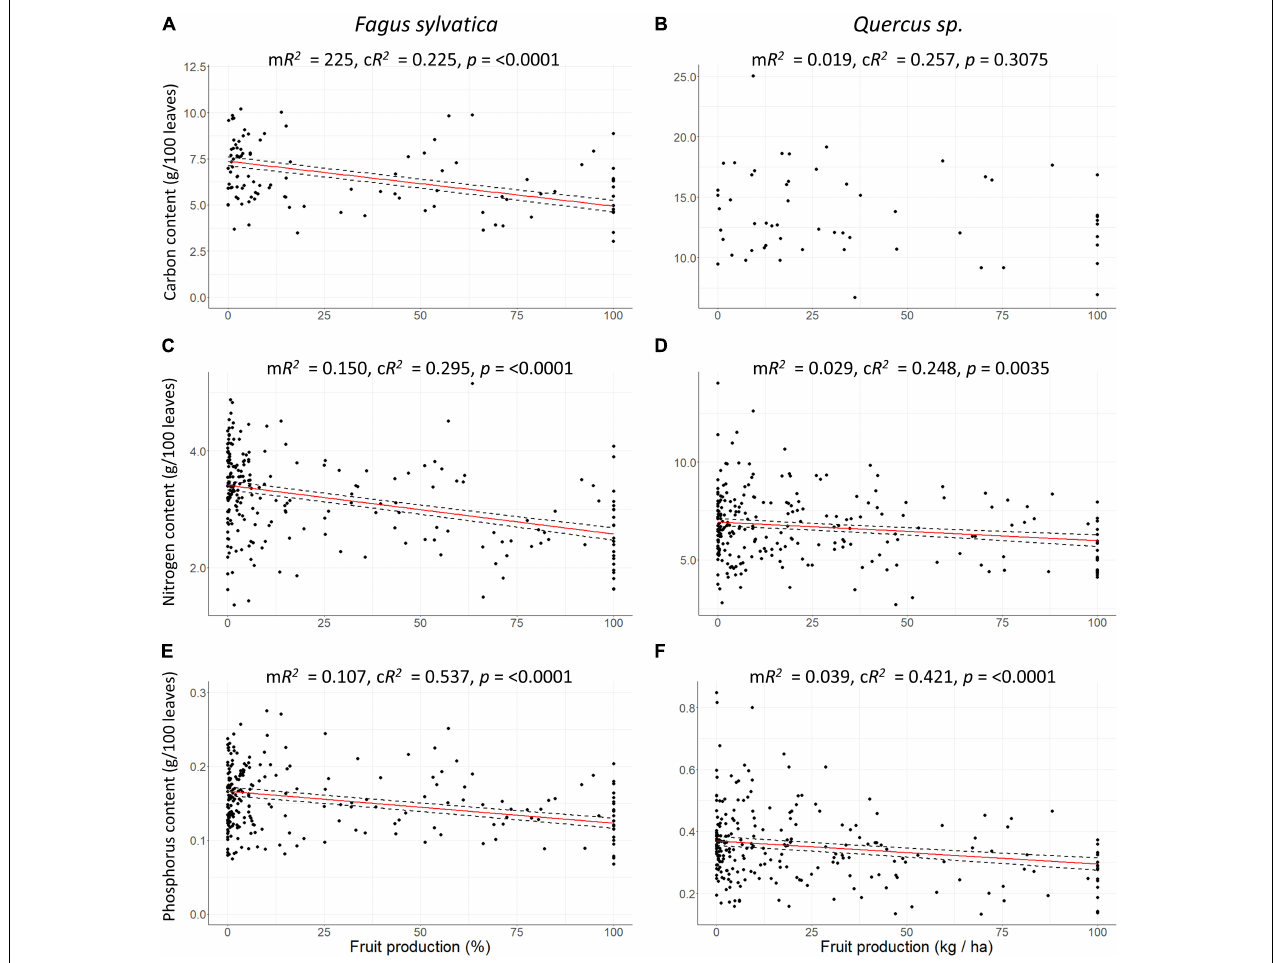
FIGURE 6 | Scatter plots of leaf carbon mass in 100 leaves (= content; g/100 leaves), nitrogen and phosphorus contents (mg/100 leaves) vs. fruit production in percentage of maximum values per plot at European scale. (A , B) carbon content, (C,D) nitrogen content, (E,F) phosphorus content, (A,C,E) Fagus sylvatica , (B,D,F) Quercus sp. Red line: Response curve of the linear mixed-effects modelling, dashed line: Standard errors, m R 2 : Marginal R 2 , c R 2 : Conditional R 2